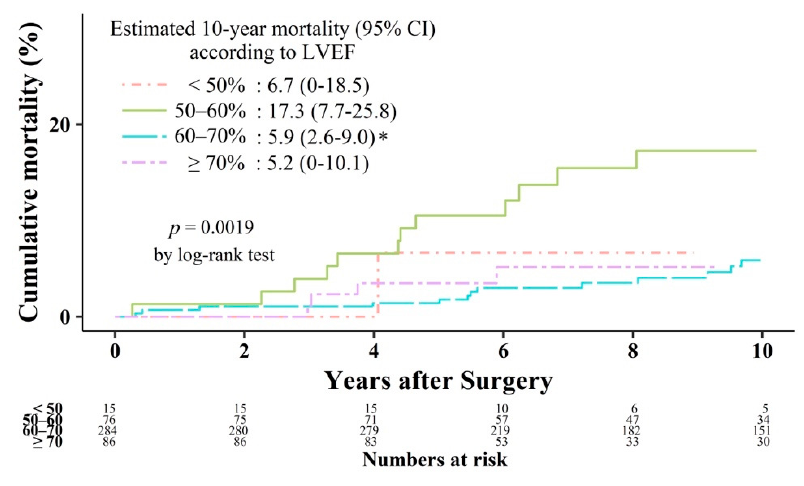
Figure 6. Kaplan–Meier curves of mortality. LVEF: left ventricular ejection fraction.